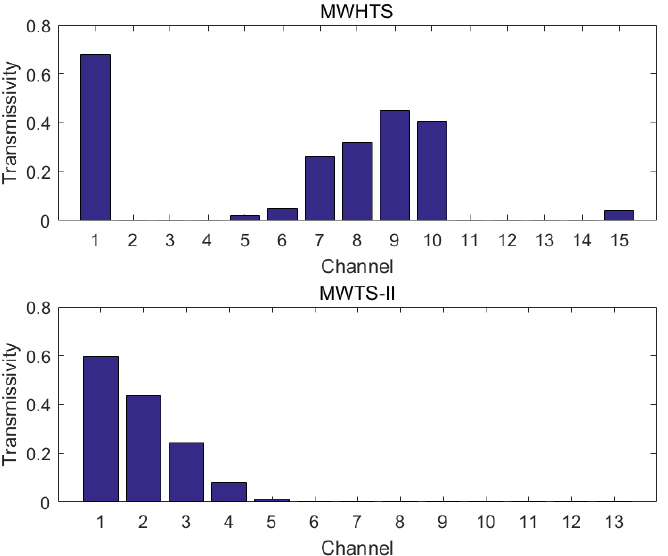
Figure 3. The mean value of the surface transmissivity, Y ( P S ,0 ) , of each channel of MWHTS and MWTS-II in the analysis dataset.